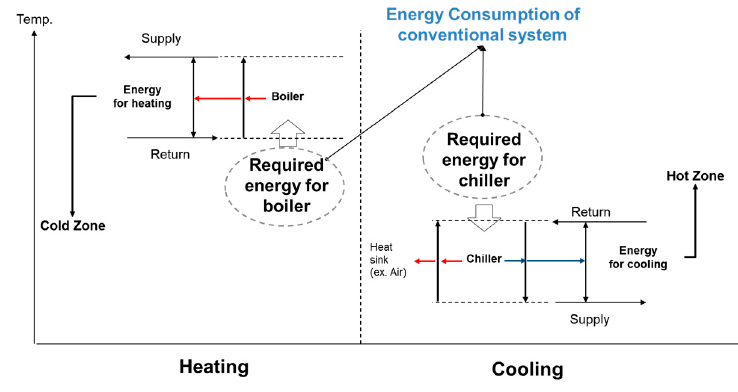
Figure 1. Concept diagrams of a conventional system.